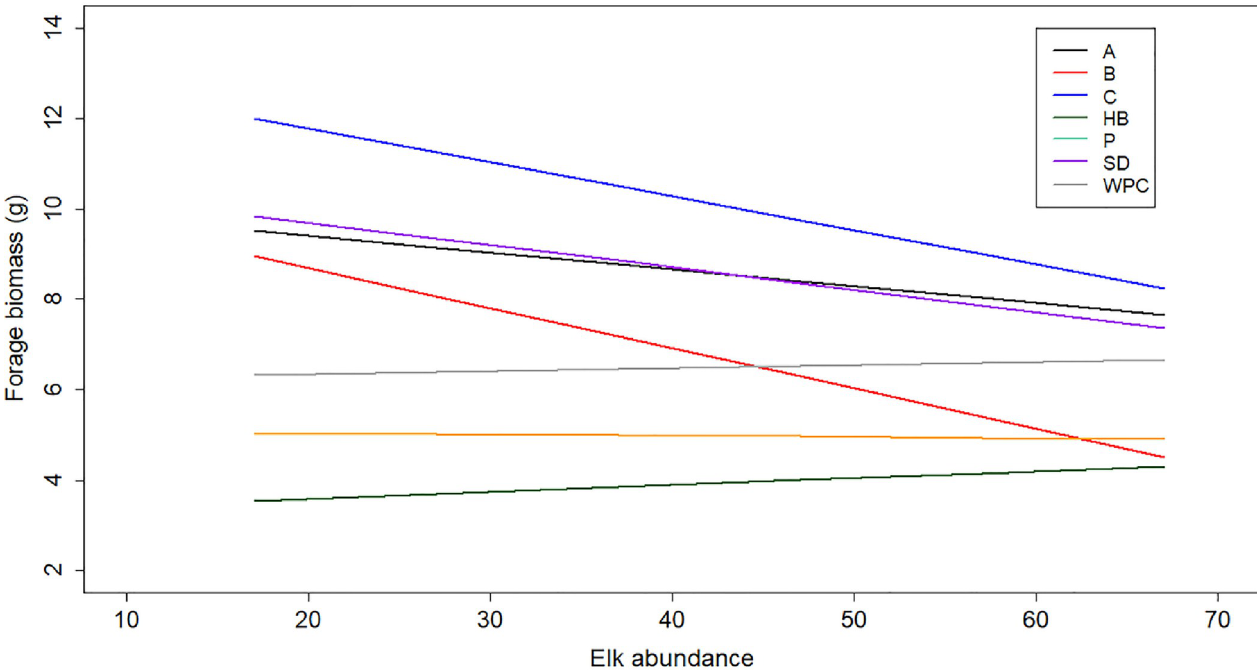
Fig 4. Scatterplot of estimated sector-specific regressions between elk abundance and forage biomass (1/4 m 2 ) from the linear mixed effect model. These regressions were estimated using mean precipitation (54.31 cm) and during the years of no herd expansion. Sector labels are the same as in Figs 1 and 3